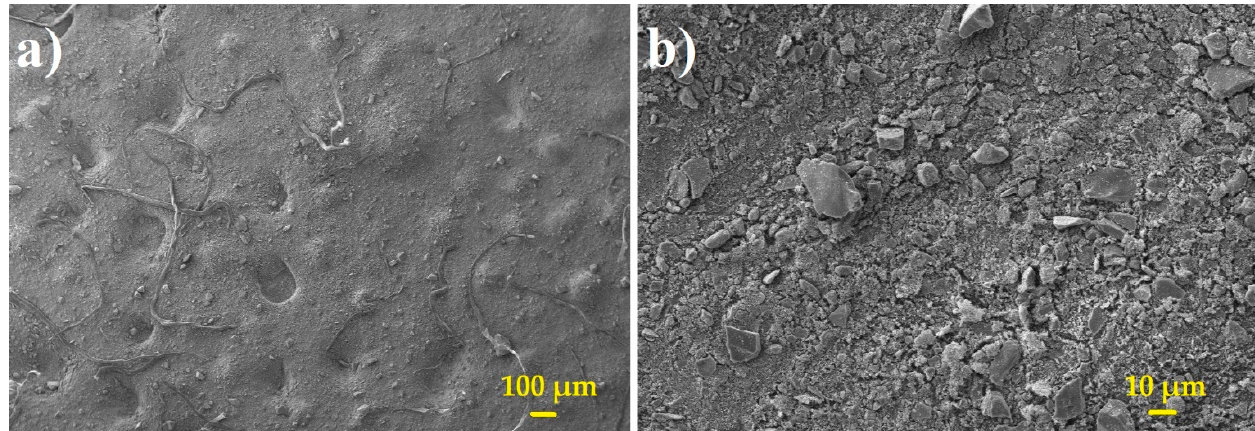
Figure 3. SEM image of ASHRAE A2 dust used in filtration experiments at magnification 100× ( a ) and 1000× ( b ).